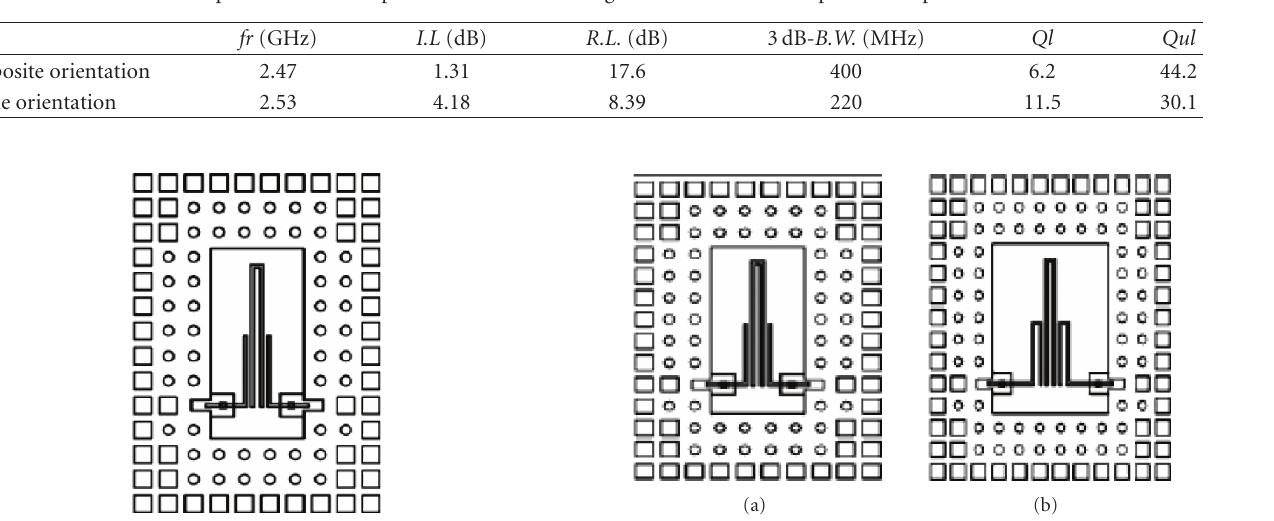
Table 3: Properties of the hair-pin resonator filter having two orientations with parallel coupled-feed lines.